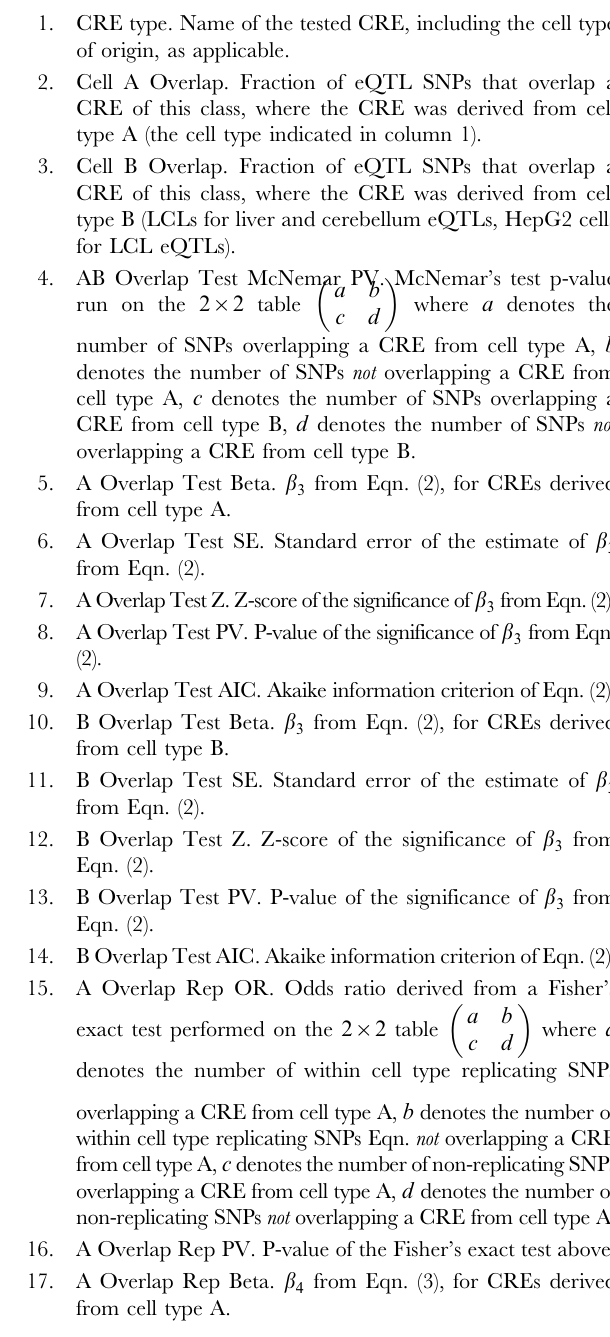
Table S4 CAP_LCL eQTL SNP enrichment/depletion within CREs: (a) relative to background, (b) replicating versus non- replicating, (c) same versus different cell types. For Tables S4, S5, and S6, eQTL SNPs ( FDR ƒ 5% ) were tested for overlap with 526 CRE data sets, each listed in a separate row. Columns are